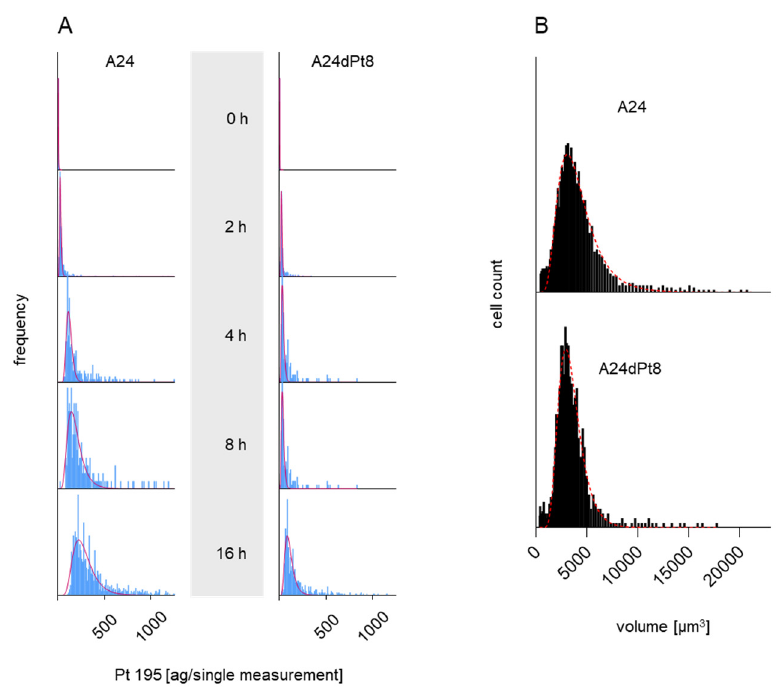
Figure 2. Frequency plot (integrated/fitted histogram; Syngistix-program PerkinElmer ) of A24 and A24dPt8 cells ( A ) incubated with 30 µM cisPt for 0, 2, 4, 8, and 16 h. ( B ) Volume distribution vs. cell count (frequency). The red curves in ( A ) and ( B ) show the lognormal fit of the frequency.